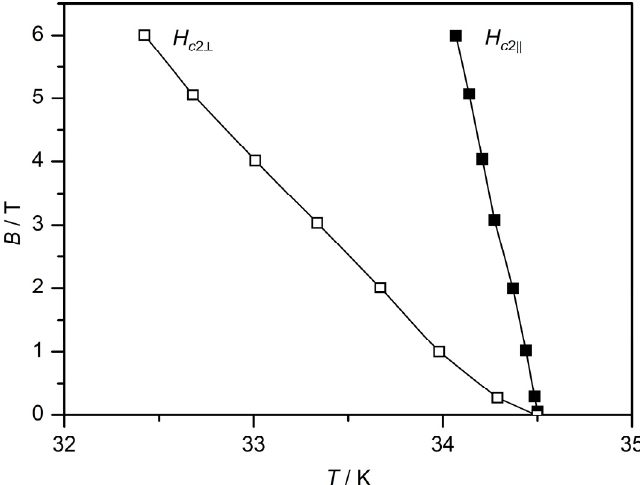
Figure 8. H – T phase diagram of Ca critical fields perpendicular and parallel to the ab plane,